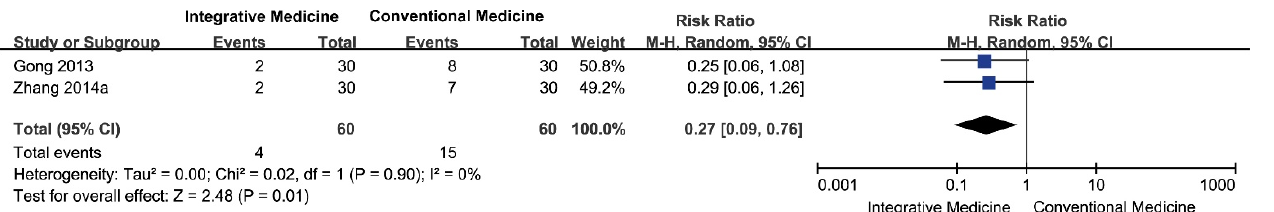
Figure 3. Forest plots of primary outcomes. ( A ) Total response rate; ( B ) recurrence rate.